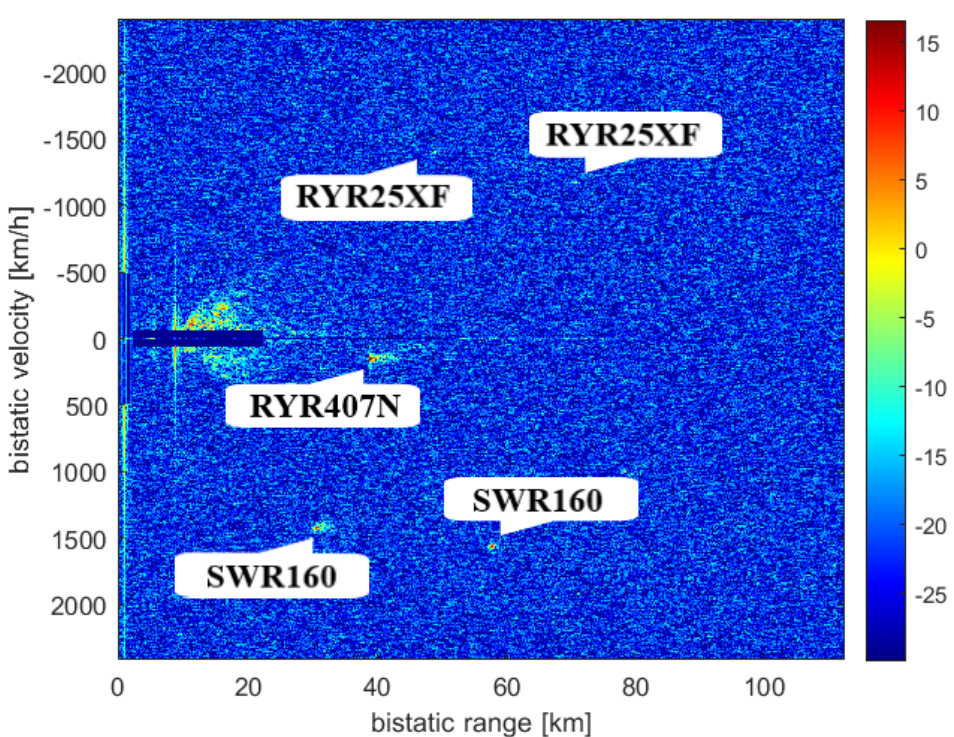
Figure 11. Range-velocity map after applying adaptive